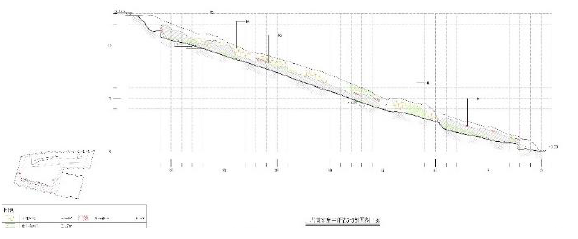
Figure 12. Condition assessment base on point cloud data by 3D laser